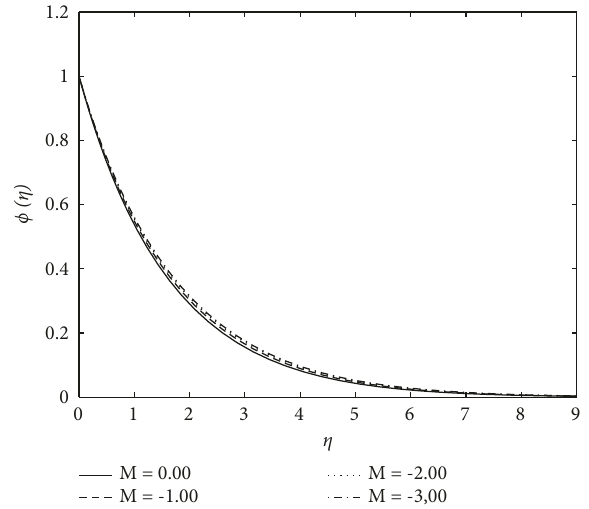
Figure 14: Change in the value of ∅ ( η ) for different values of M .